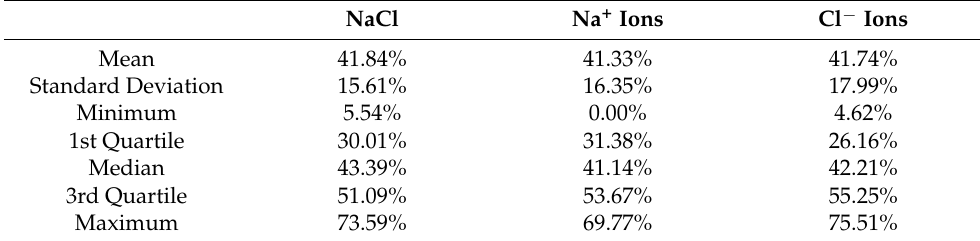
Table 1. Desalination statistics: data: Appendix A, Table A2. Values are the proportion removed. NaCl Na +